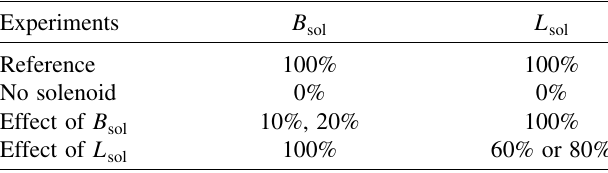
TABLE II. Experimental conditions of solenoid field.